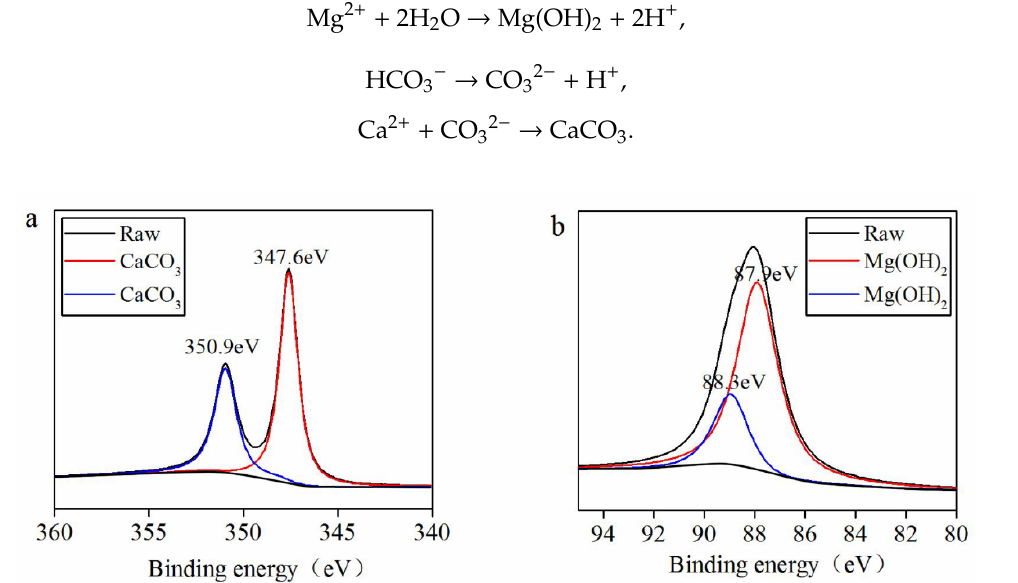
Figure 10. XPS spectrum of Ca 2p ( a ) and Mg 2p ( b ) on the worn surface of the GCr15 disc sliding against the SN10 pin in a seawater environment.